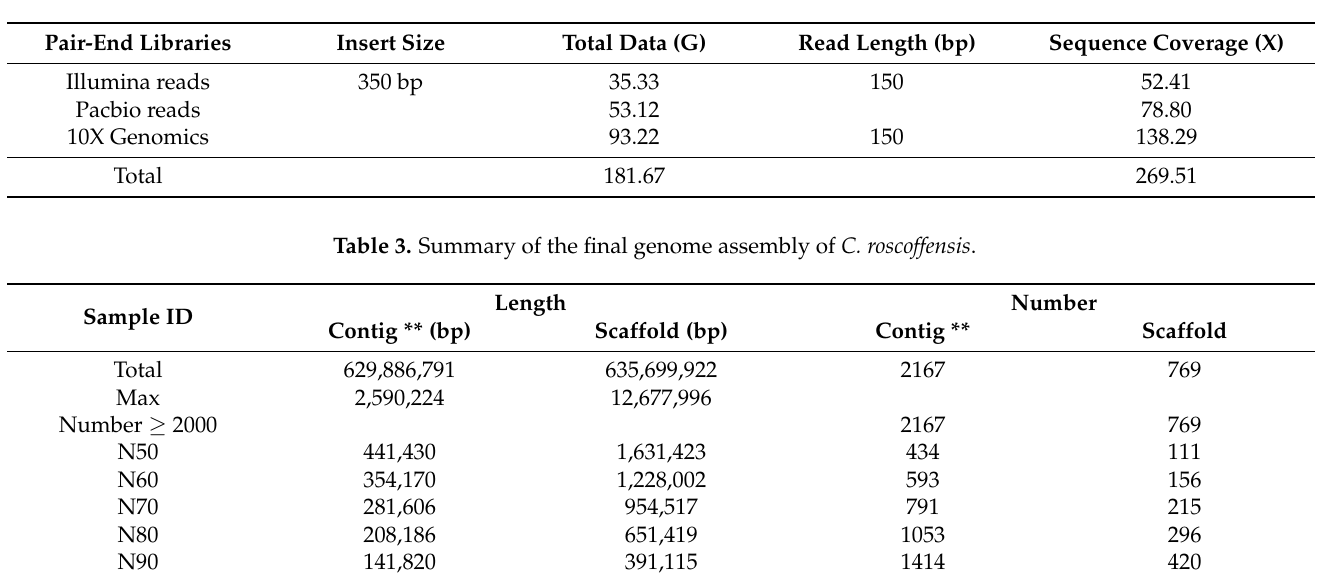
Table 2. Sequencing data statistics of C. roscoffensis .